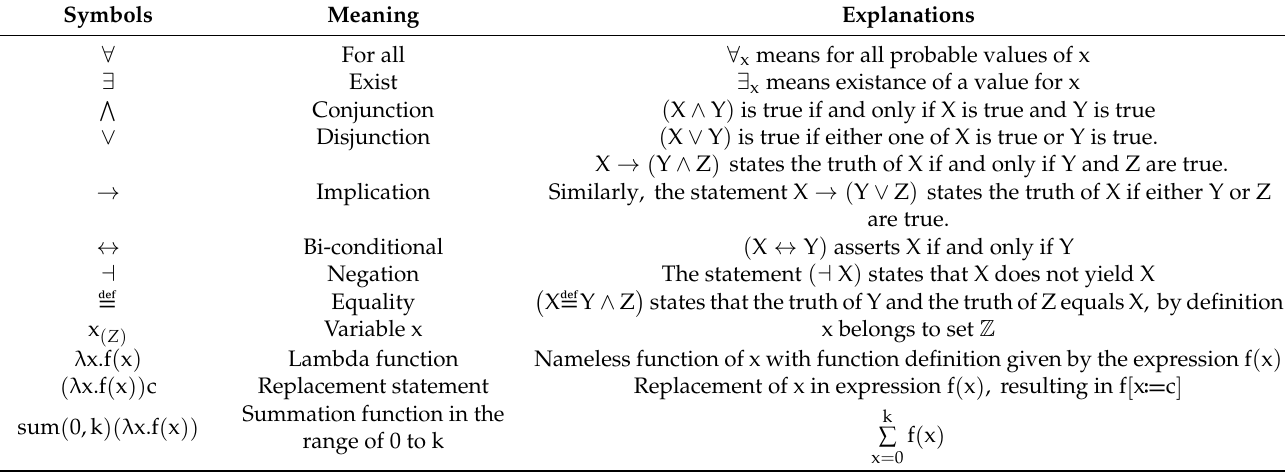
Table 2. Some logical symbols of HOL.